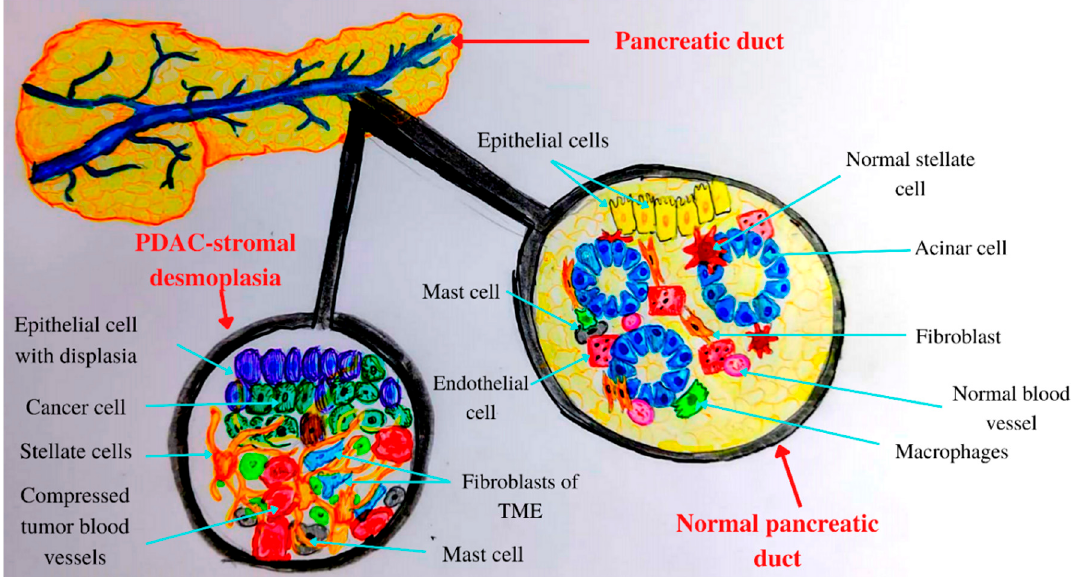
Figure 1. Anatomical and histological features of the pancreas: normal versus PADC.